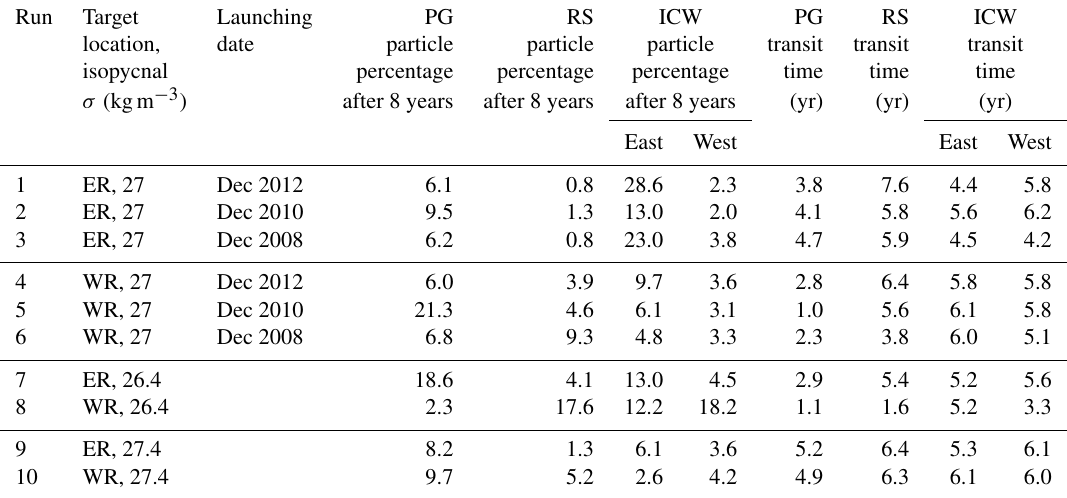
Table 1. Trajectory calculations of percentages and transit times of advective Lagrangian particles for different runs performed with a length of 8 years on different isopycnals ( σ = 26 . 4, 27, 27.4kgm − 3 ) for this study. Transit times are defined by the times when 50% of the particles crossed the section from the three major source regions (PG, RS, and southern Indian Ocean) to the two release areas (ER and WR). Percentages refer to the total number of Lagrangian particles that crossed the section during the simulation (8 years). Release locations are defined as circles with a radius twice the grid spacing, thus 1 / 6 ◦ , around the coordinates of the release points (abbreviations defined in Sect. 2.2). The number of released floats is 10000 for all runs that are listed